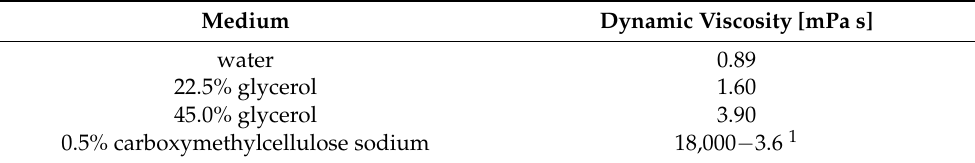
Table 1. Liquid media used in the dissolution